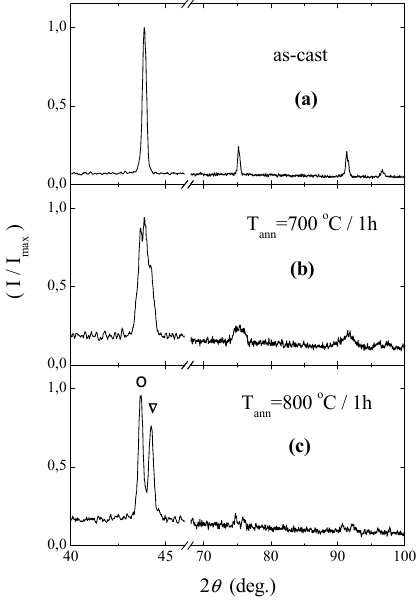
Figure 31. Effect of thermal treatment on X-ray diffraction spectrum of Co 29 Ni 25 Cu 45 Mn alloy microwire. Reproduced from reference [98], Figure 1.